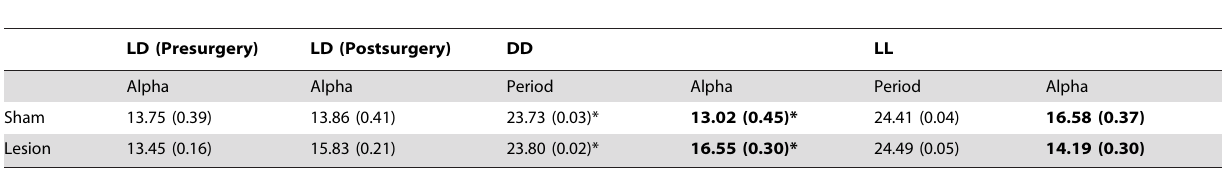
Table 1 . Means (SE) for period and alpha in hours during LD, DD and LL conditions for shams and grass rats with IGL lesions.